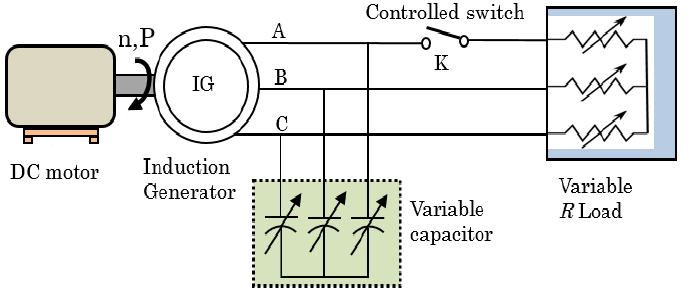
Figure 16. Self-excited induction generator connected to a resistive balanced and unbalanced load.